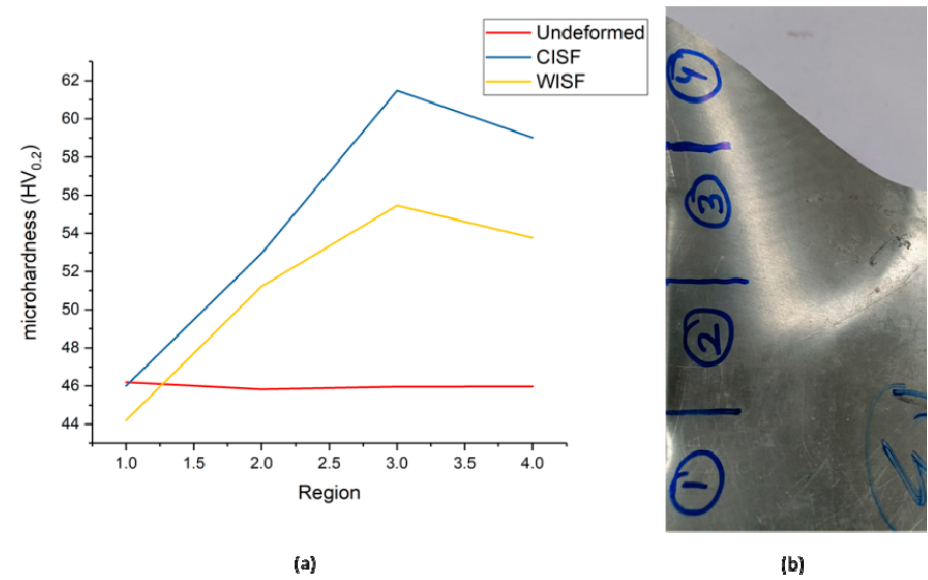
Figure 16. ( a ) Microhardness plot for various regions in undeformed sheet and ( b ) cones formed by